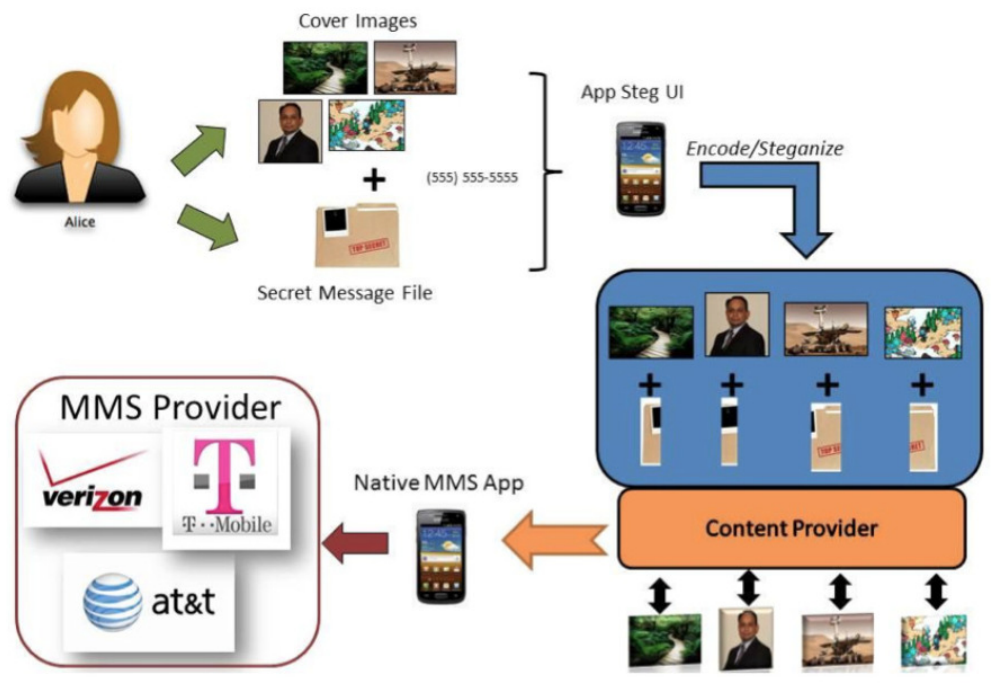
Figure 3: The process of extracting the secret message from a Steganographic MMS